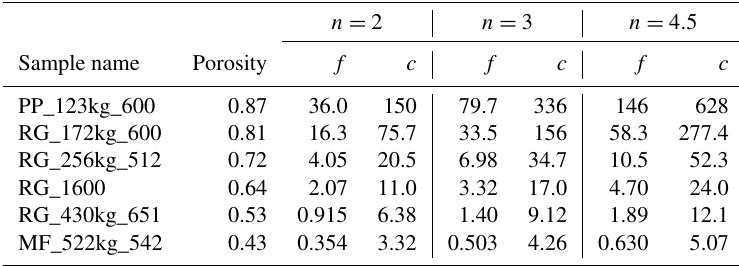
Table 3. Optimal values for the parameters f and c of the Abouaf equivalent stress (Eq. 25) for three n values. n = 2 n = 3 n = 4 . 5